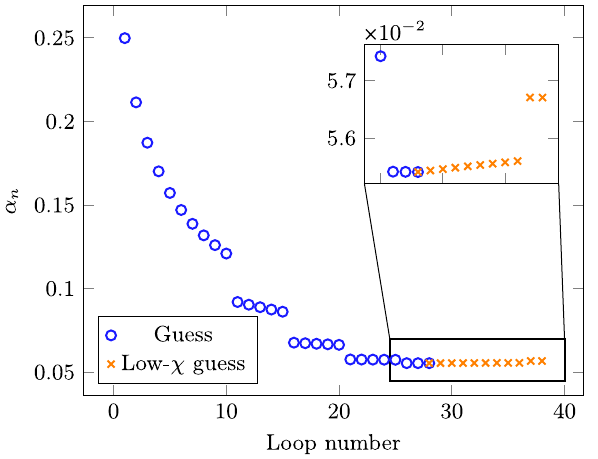
FIG. 7. Comparisonof loopcount n andmean-field amplitude α when using a simple, unguided guess at bond dimension χ ¼ 100 and when using the χ ¼ 100 converged amplitudes as a guess for χ ¼ 200 . The system parameters are L ¼ 60 , U ¼ − 10 t , t ⊥ ¼ 0 . 3 t , β t ¼ 9 . 5948 , and χ ¼ 100 (blue circles) and χ ¼ 200 (orange crosses). The MF terms in both cases have range r ¼ 1